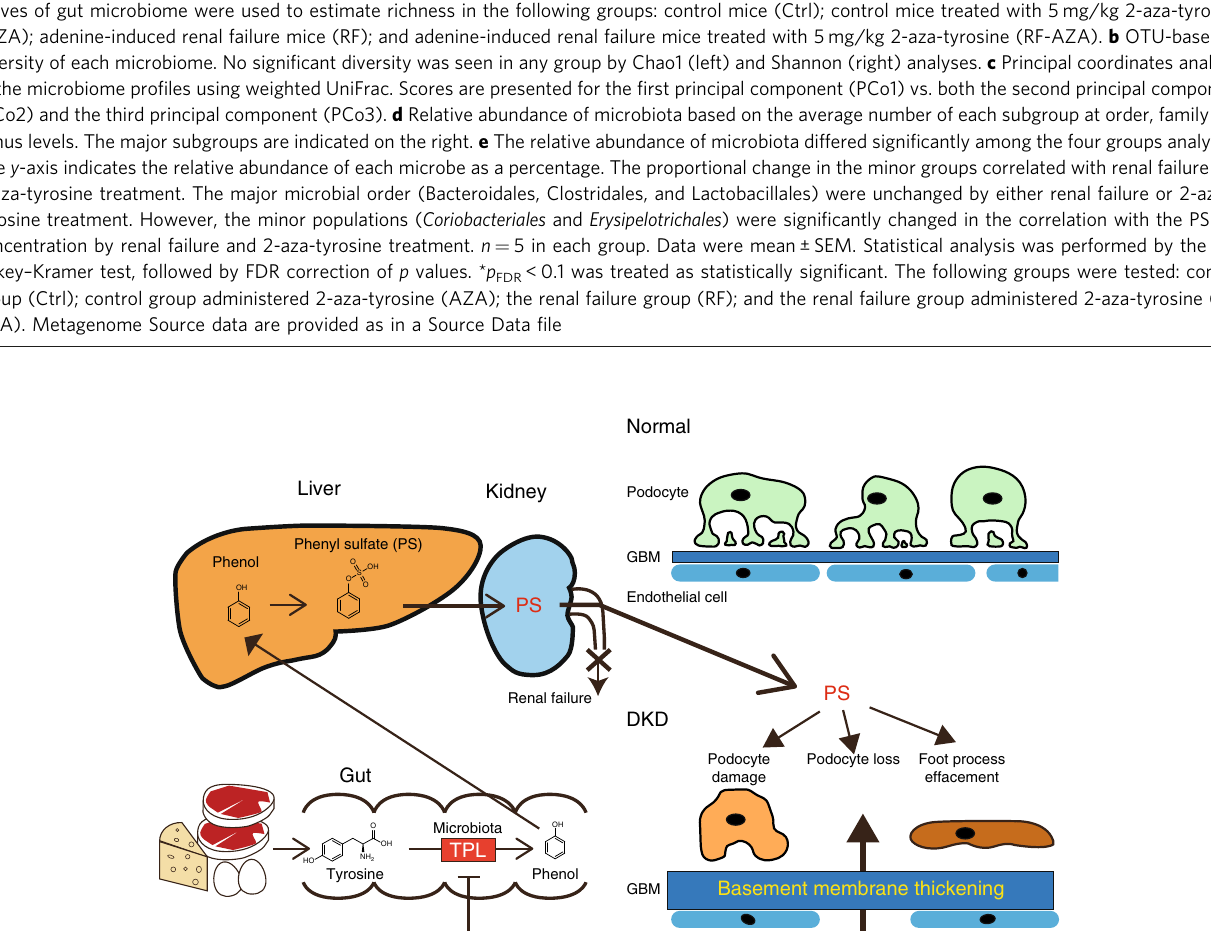
Fig. 6 A schematic model of the generation and toxicity of PS. In gut microbiota, TPL converts tyrosine to phenol and ammonia. PS is also generated in the liver. PS accumulates in plasma as a metabolite and has deleterious effects on the vasculature and kidneys. In diabetic kidney disease, PS damages podocytes, accelerates GBM thickening, and induces proteinuria. Treatment with TPL inhibitors reduces plasma PS levels and prevents the progression of renal failure in animal